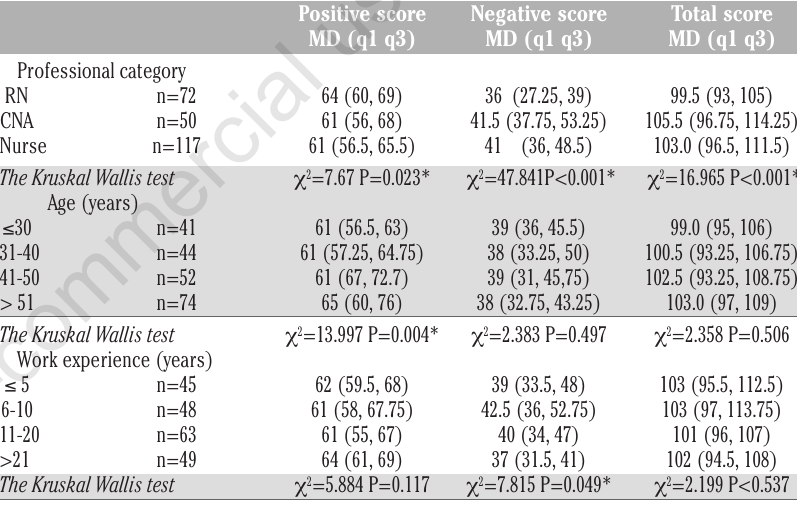
Table 1. Positive score, negative score and total score across professional category, age and work experience groups.